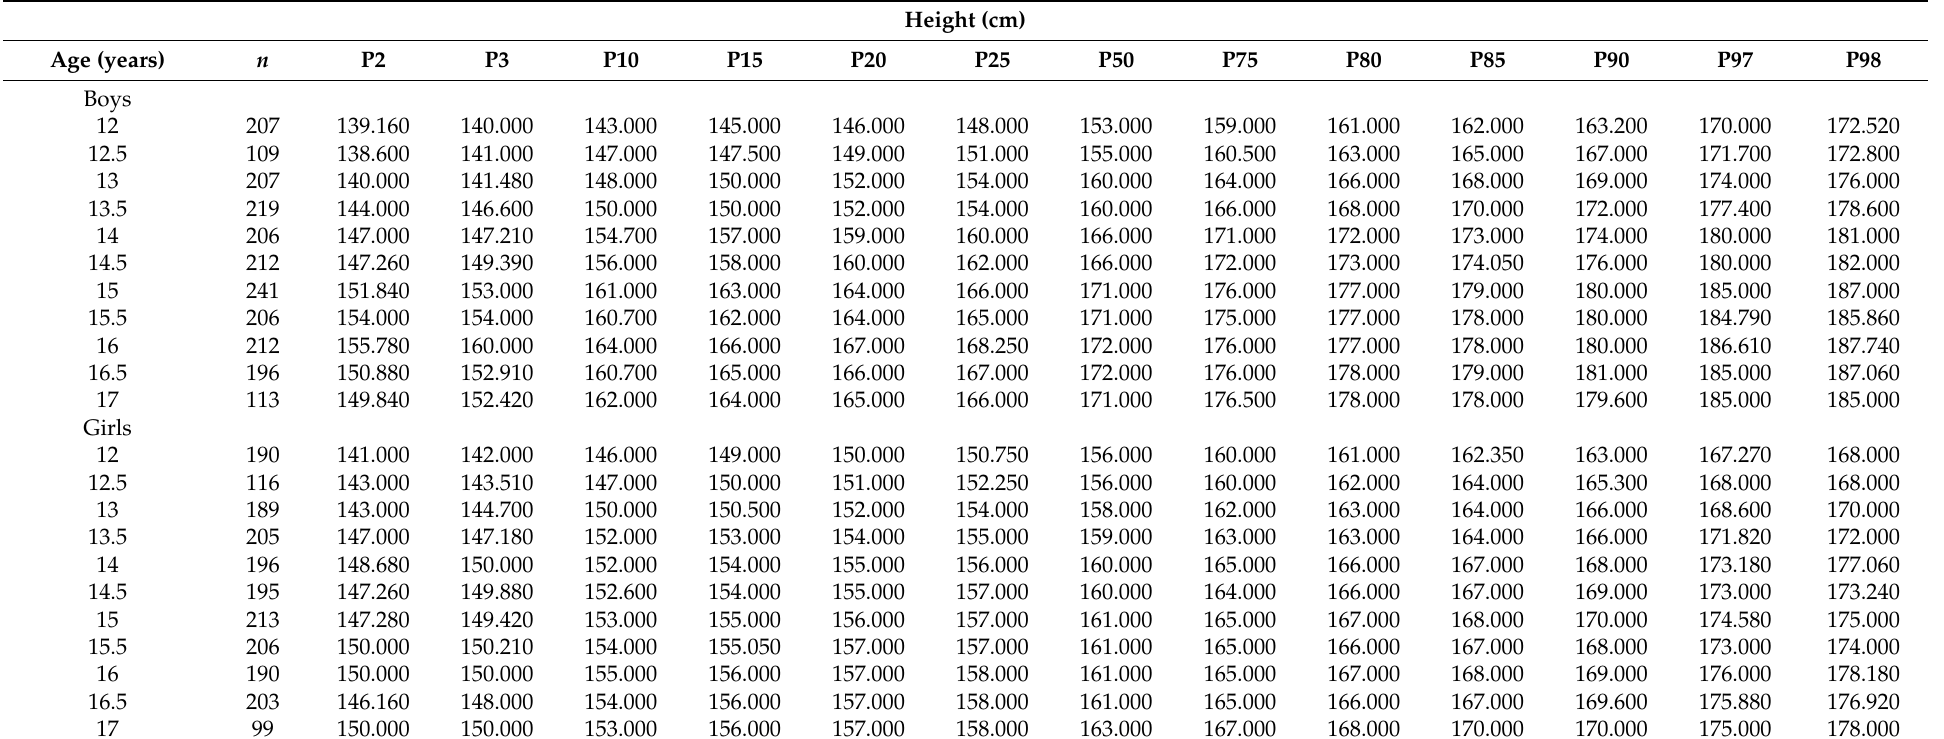
Table 5. Percentile distribution outcomes of height by gender and